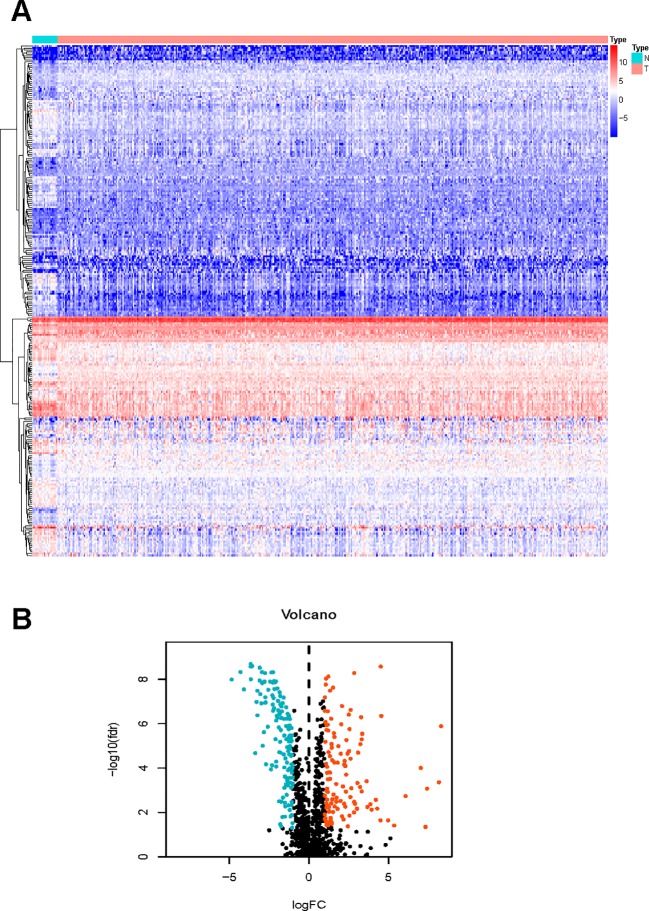
Differentially expressed immune‐related genes. Heatmap (A) and a volcano plot (B).